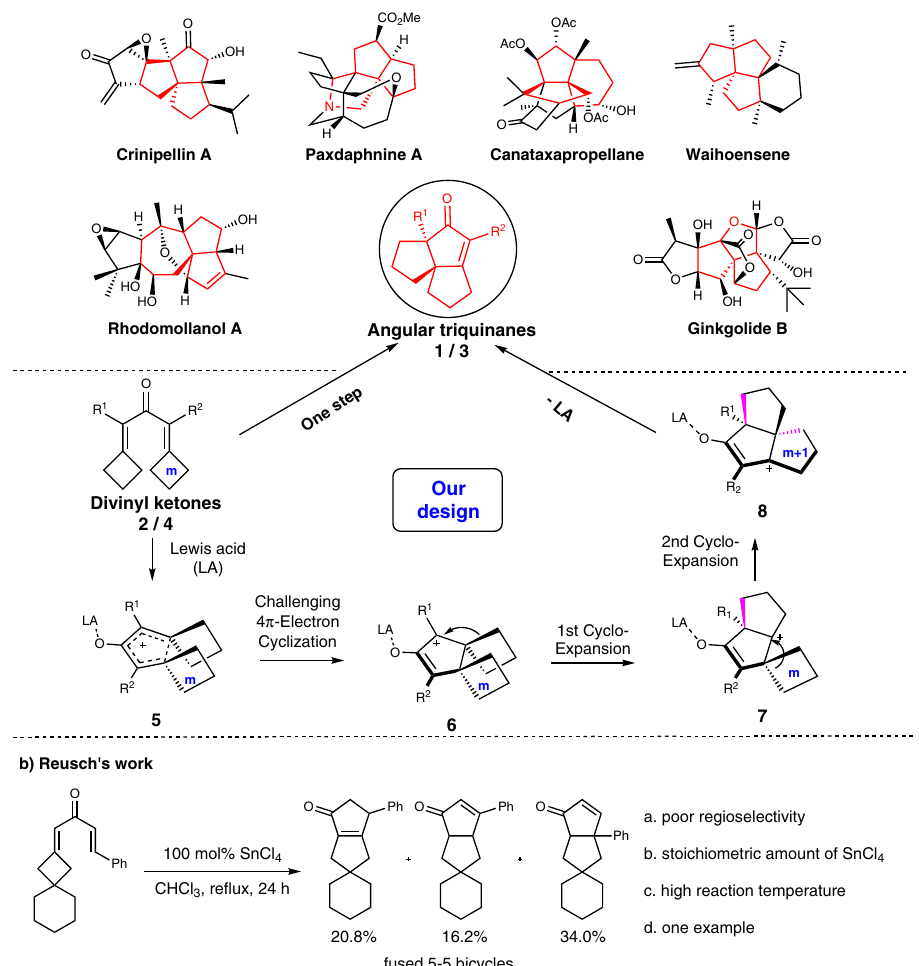
Fig. 1 Proposed tandem of Nazarov cyclization and two ring expansions to consturct angular triquinanes and representative bioactive natural products. a Our design and representative bioactive natural products; b Reusch ′ s work 25